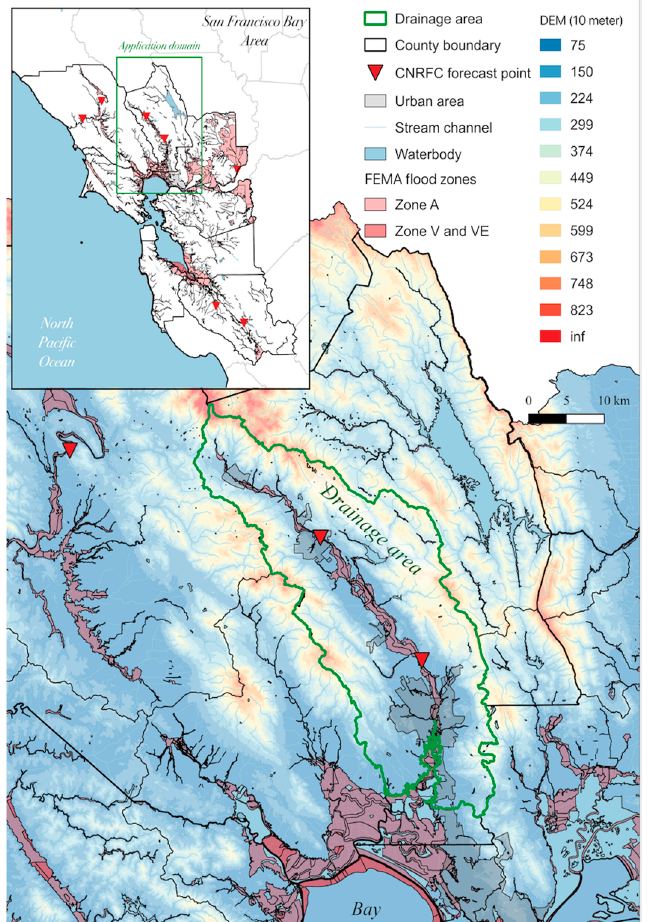
Figure 1. Map showing important geographic features in the region around San Pablo Bay at the northern end of San Francisco Bay where the case study described in the text was conducted. Insert shows the location relative to the greater San Francisco Bay area. The legend indicates color shading for elevation (m), Federal Emergency Mangement Agency (FEMA) flood zones A (Areas with a 1% annual chance of flooding), V and VE (Coastal areas with a 1% or greater chance of flooding and an additional hazard associated with storm waves), urban regions, and water bodies. The outline of the Napa river watershed, stream channels, and county boundaries are indicated by line colors corresponding to the legend. CNRFC forecast points are identified by inverted red triangles.